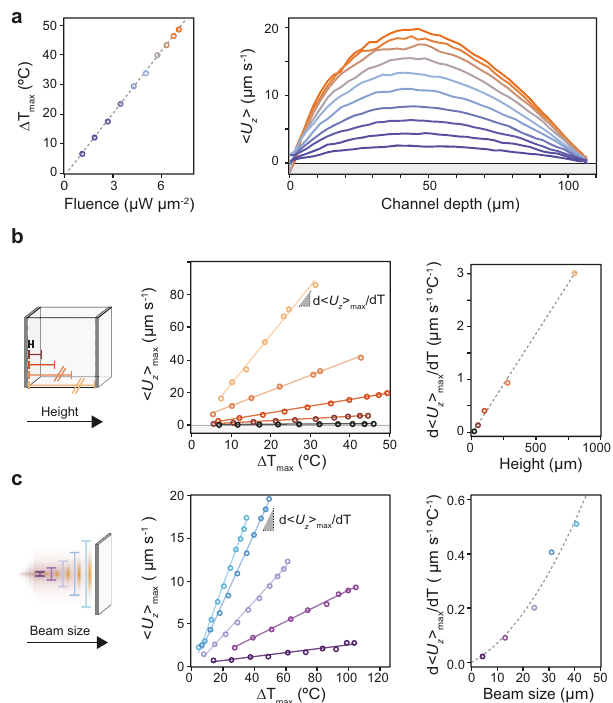
Fig. 5 Power, chamber height, and beam size dependence of the plasmonically induced convective laminar fl ow. a Peak temperature difference as a function of pump fl uence (left), and the corresponding plane averaged U z fl ow velocity pro fi les (right) for a sample with a channel height of 100 µ m and a pump beam size of 30 µ m. b In fl uence of channel height on the maximum laminar fl ow velocity achieved within the channel for samples with a fi xed pump beam size of 30 µ m for different peak temperature gradients (left). To determine the dependence between fl ow velocity and channel depth robustly, i.e., accounting for glass substrate heterogeneity and therefore slightly different temperature pro fi les between experiments, the slope from each of the previous curves is plotted as a function of channel depth (right). c Same as (b) except we probe the in fl uence of pump beam size (heat source) on the maximum fl ow velocity for samples with a fi xed channel height of 100 µ m. Dashed and solid lines all correspond to fi ts to the data. Colors encode the parameter value ( fl uence, chamber height, and pump beam size) varied during each